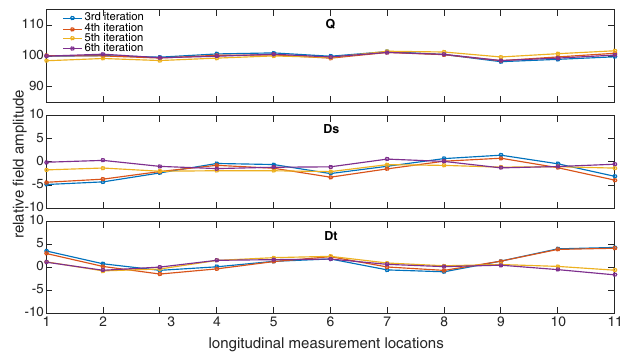
FIG. 14. The plot shows the change of the field distribution of the Q, Ds, and Dt components for the 3rd to the 6th tuning iteration.